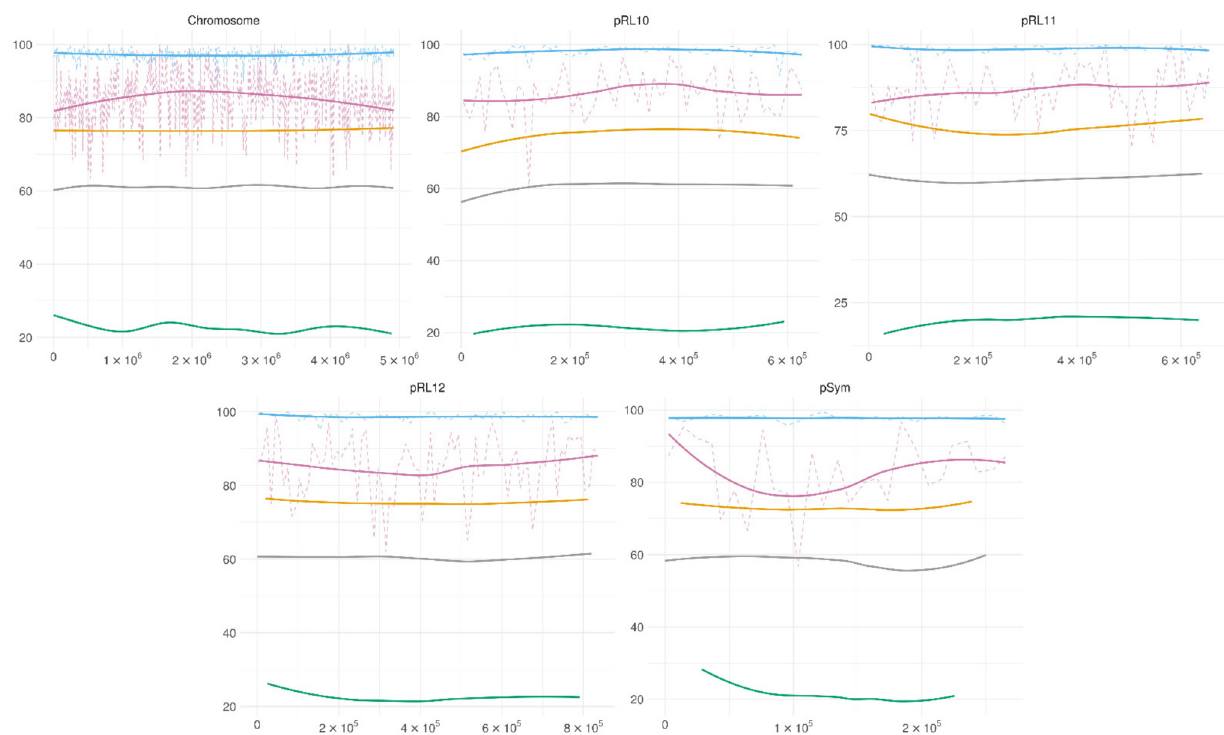
Figure 4. GANTC methylation across the replicons. Blue—GANTC motif methylation in bacteroids, purple—GANTC motif methylation in cell culture, yellow—methylation of adenine in bacteroids, green—methylation of adenine in cell culture, grey—GC content. Solid lines—polynomial regression lines calculated using ggplot_smooth “loess” method, formula “y~x,”; dotted lines represent the average methylation across a 5 kb sliding window.